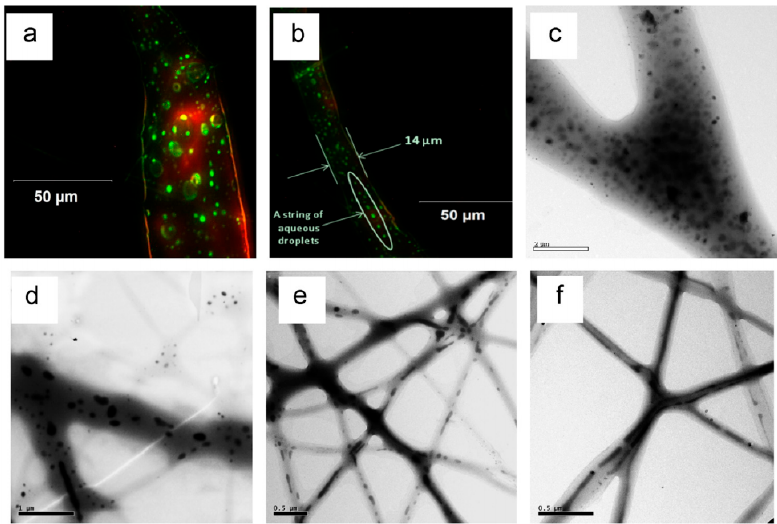
Figure 15. Morphological evaluation of the water phase in electrospun fibers collected at different locations of the emulsion jet path: ( a , b ) fluorescence microscopy images of fibers; ( c – f ) TEM micrographs at different magnifications. Pictures are from [148]. Reproduced with permission from Wang, C., et al., Materials Letters ; published by Elsevier, 2014.